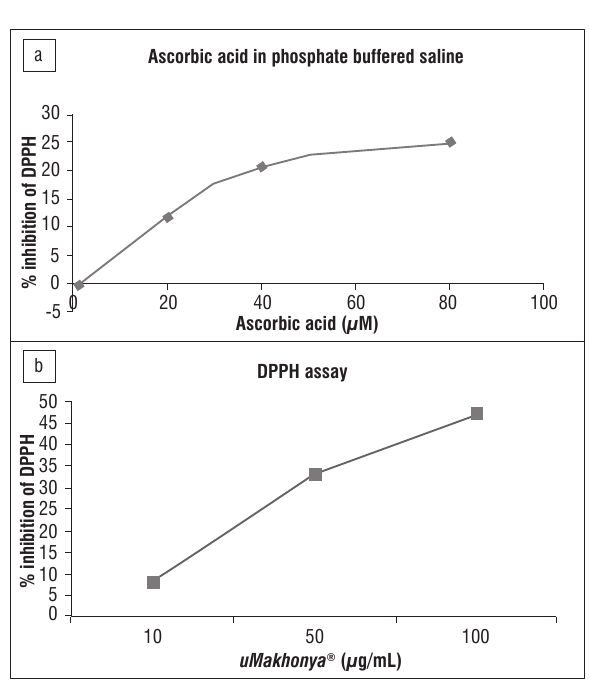
Figure 4: Reduction of 1,1-diphenyl-2-picryl-hydrazyl (DPPH) salt (200 µM) as a measure of (a) the antioxidant potential of ascorbic acid doses (b) and uMakhonya ® doses